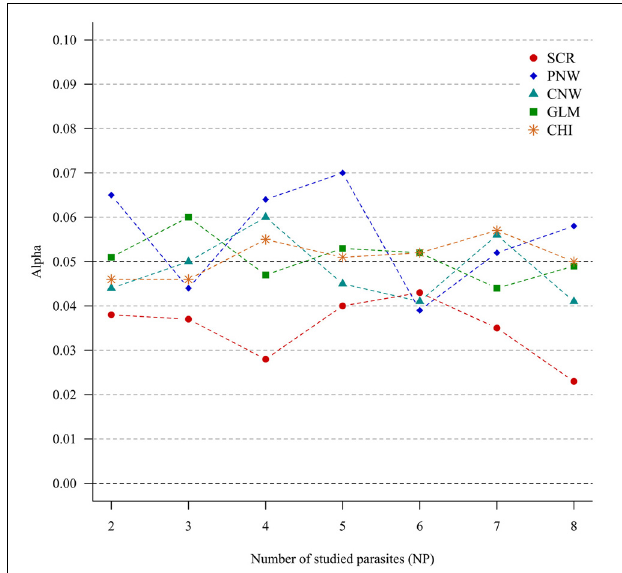
FIGURE 1 | Simulation outputs relative to the test of the sensitivity ( α ) for the four approaches. CHI, generalized chi-square test; PNW, parasite network model; CNW, combination network model; GLM, multinomial GLM model and SCR, the association screening approach. The number of parasites varied from two to eight, the size of the total host population was fixed to 1000.